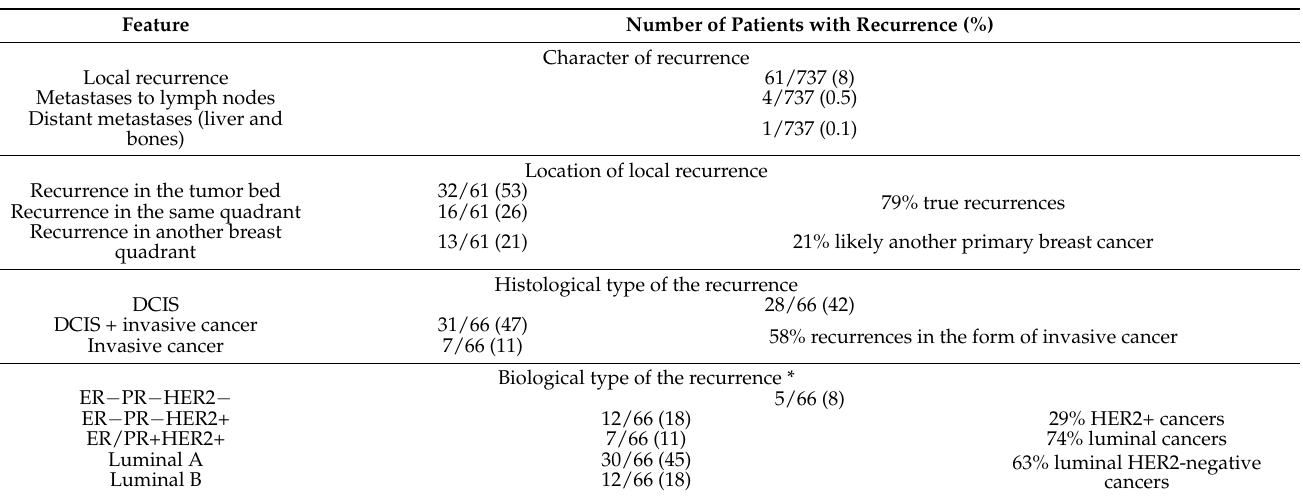
Table 2. Pooled characteristics of 66 recurrences in 737 DCIS